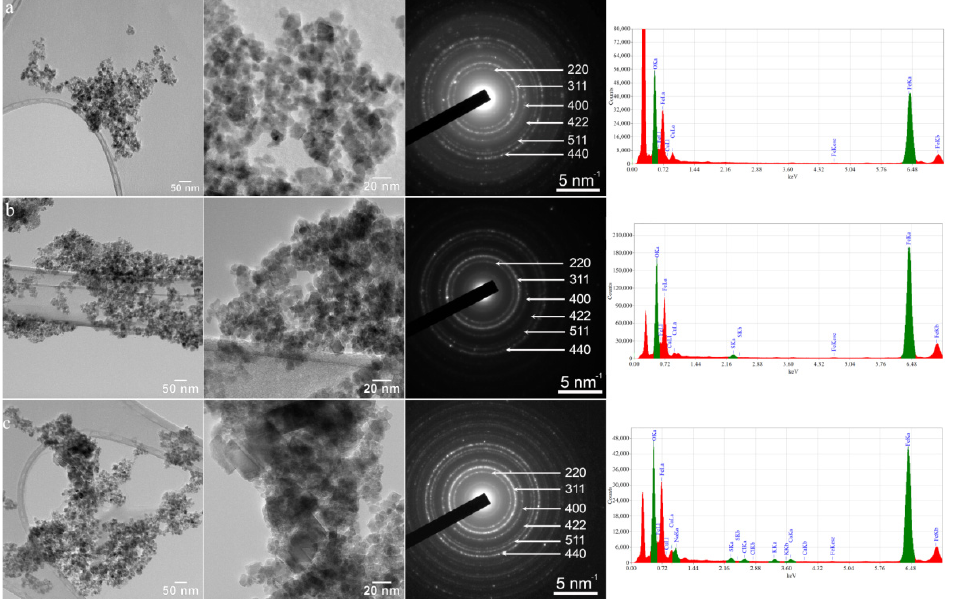
Figure 1. CTEM images, SAED patterns and EDXS spectra for: ( a ) Fe 3 O 4 , ( b ) Fe 3 O 4 -L-Cys and ( c ) Fe 3 O 4 -L-Cys-Dox NPs.